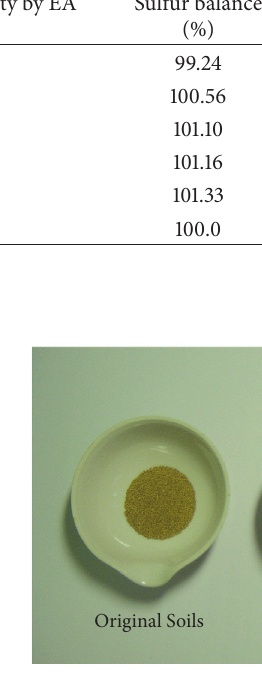
Figure 3: The photograph of Loupi soil before and after H 2 S chemisorption